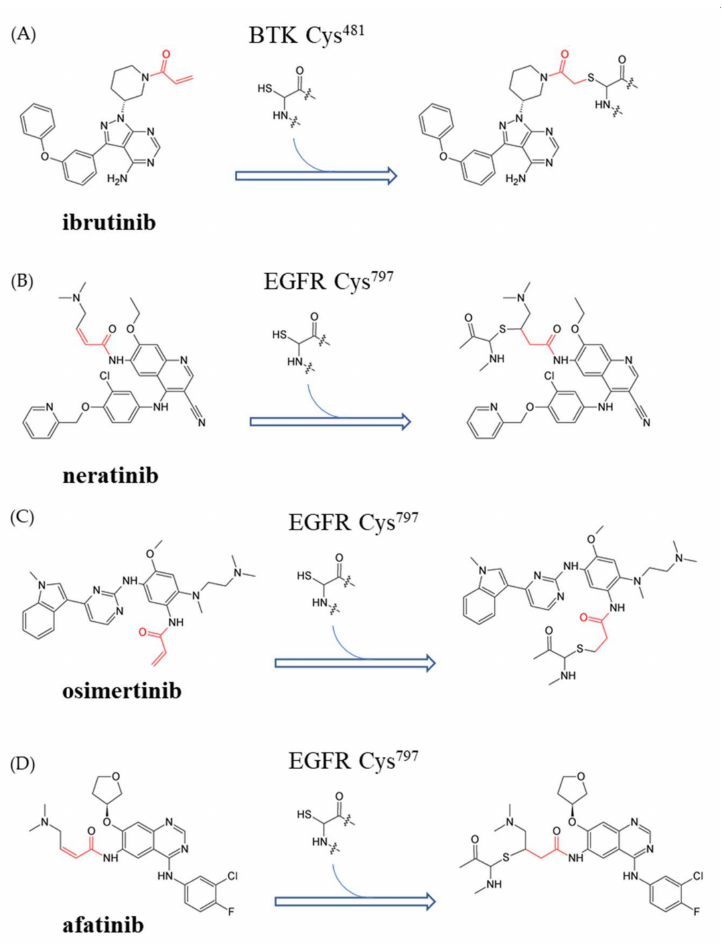
Figure 2. Covalent drugs bind to their target protein by forming a covalent bond with the amino acid. Ibrutinib is a covalent inhibitor of Bruton’s tyrosine kinase (BTK), and the mechanism is used to block the active site by forming a covalent bond between the α , β -unsaturated carbonyl motif, and cysteine-481 of BTK ( A ). Neratinib ( B ), osimertinib ( C ), and afatinib ( D ) have been developed for the inhibition of EGFR activity. The three compounds selectively bind to the active site (containing cysteine-797) of EGFR via a covalent